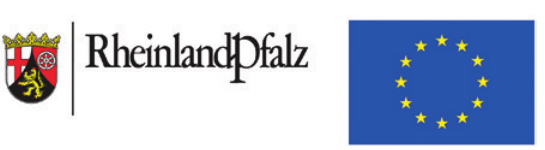
Figure 6: This research was supported by the European Regional